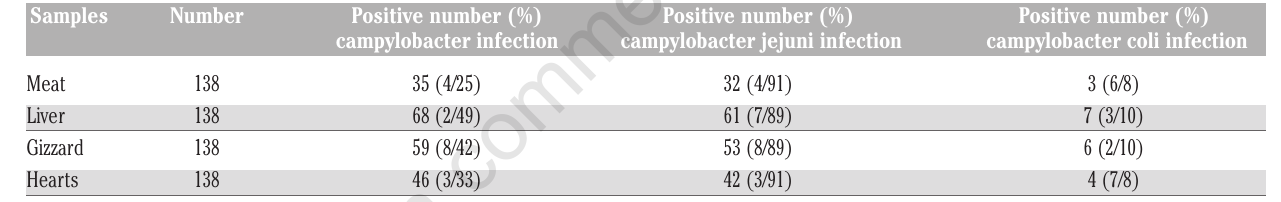
Table 2. The contamination of chicken meat and its related edible offal to Campylobacter and its species. Samples